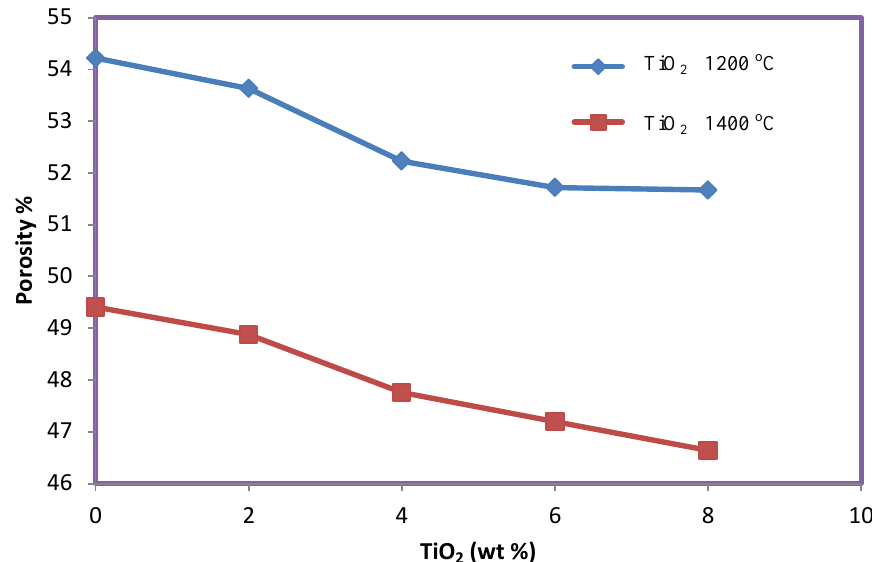
Fig. 6: The porosity of spinel MA sample with additives (TiO 5-Thermal conductivity